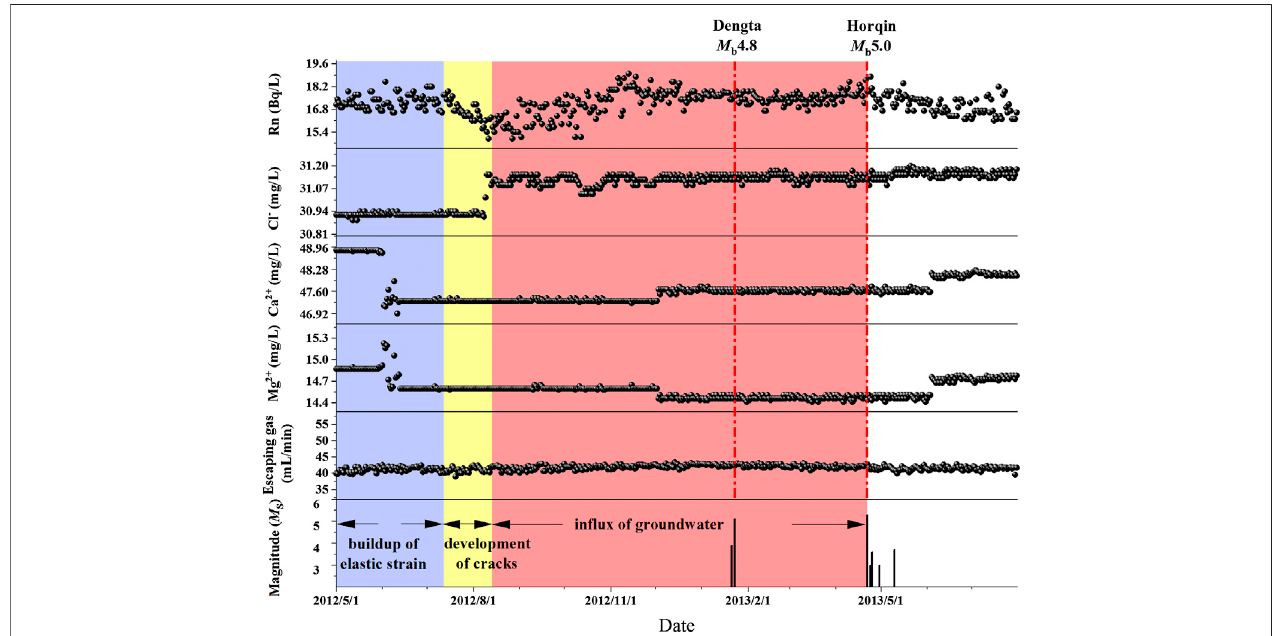
FIGURE5| Timeseriesofwaterradon,Cl − ,Ca 2+ ,andMg 2+ concentrationsandescapinggas fl owatthePanjinobservationwellandtheirrelationshipstothe2013 Dengta Mb 4.8 and Horqin Mb 5.0 earthquakes (shown by red dashed lines). The bottom panel shows M ≥ 3 foreshock and aftershock of the Dengta and Horqin earthquakes (http://www.csi.ac.cn/). Blue shading shows the buildup of elastic strain; yellow shading shows the development of cracks; and red shading shows the in fl ux of groundwater.